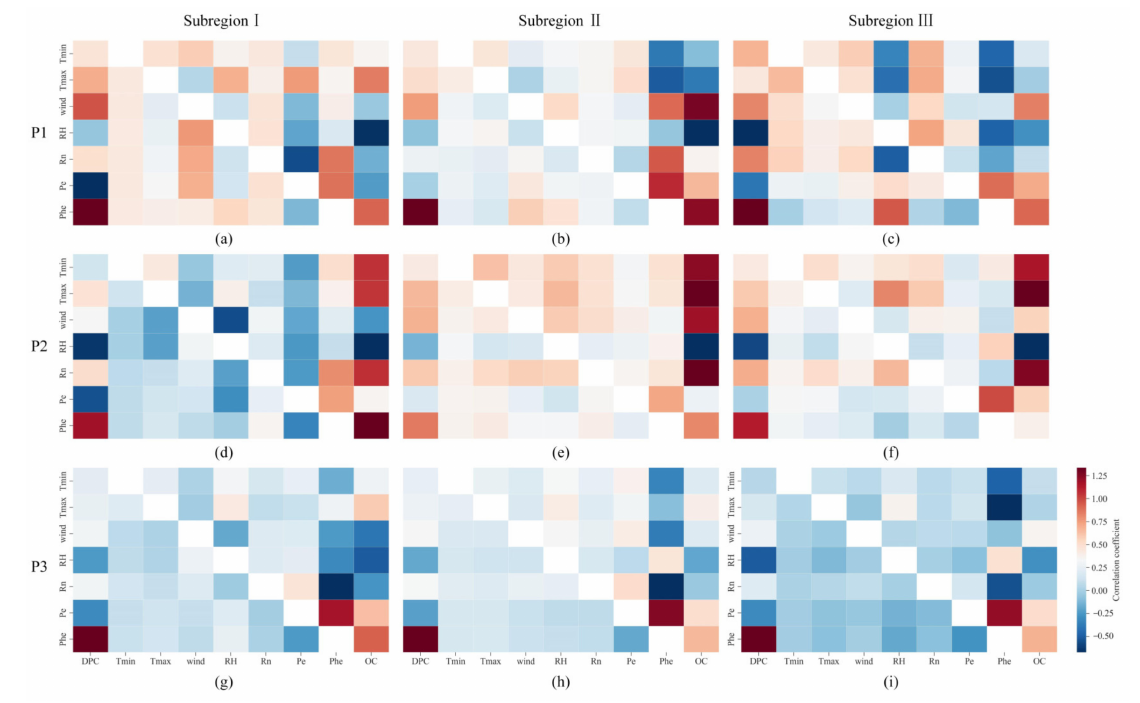
Figure 5. Each factor on the path analysis chart for the irrigation water requirements of winter wheat in spatial distribution in P1 ( a – c ), P2 ( d – f ) and P3 ( g – i ) stages in subregions I ( a , d , g ), II ( b , e , h ) and III ( c , f , i ) (DPC represents the direct path coefficients, OC represents the overall correlation coefficients and the rest are indirect path coefficients).